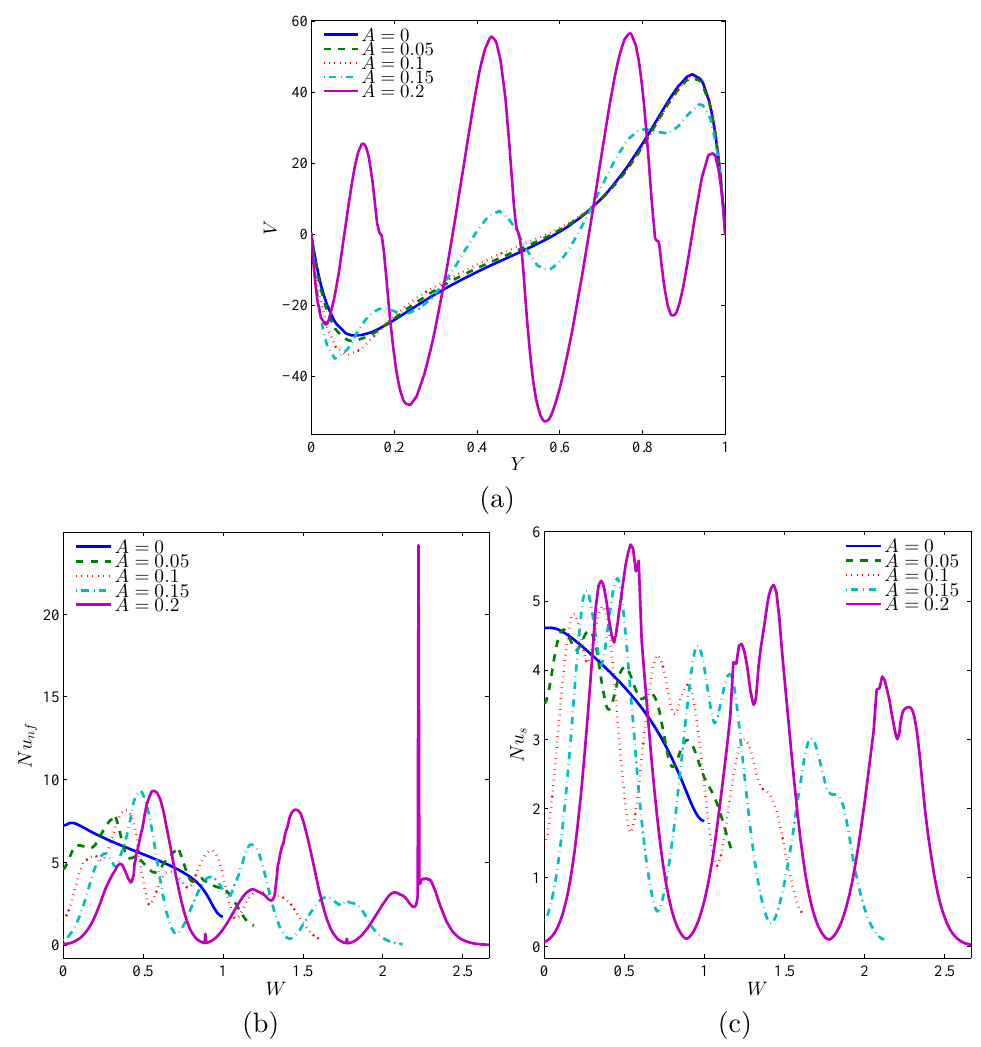
Figure 10. Local velocity ( a ), the local Nusselt number of the nanofluid phase ( b ), and the local Nusselt number of the solid phase ( c ) with the vertical line ( Y ) for X = 0.5 for different N values; Da = 10 − 3 , φ = 0.02, γ = 10, and ε =